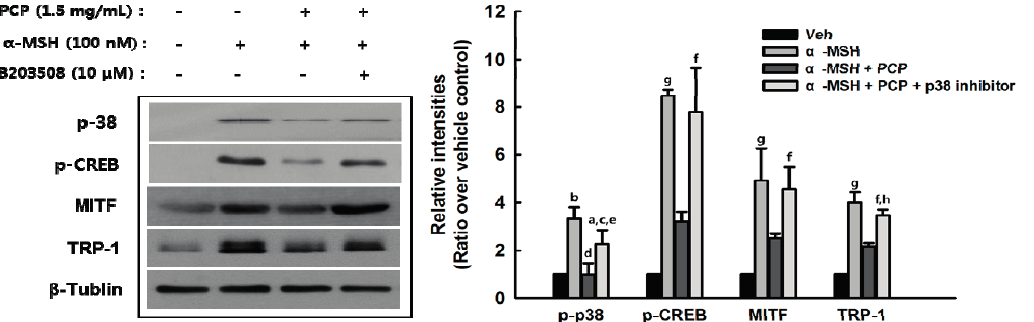
Figure 8. B16F10 cells were incubated with 10 μ M SB203508 for 1 h before 1.5 mg/mL PCP for 48 h following treatment with or without α -MSH (100 nM) for 24 h. 38 MAPK, p-38, p-CREB, MITF, TRP-1, and β -tublin examined by Western blot analysis. PCP =